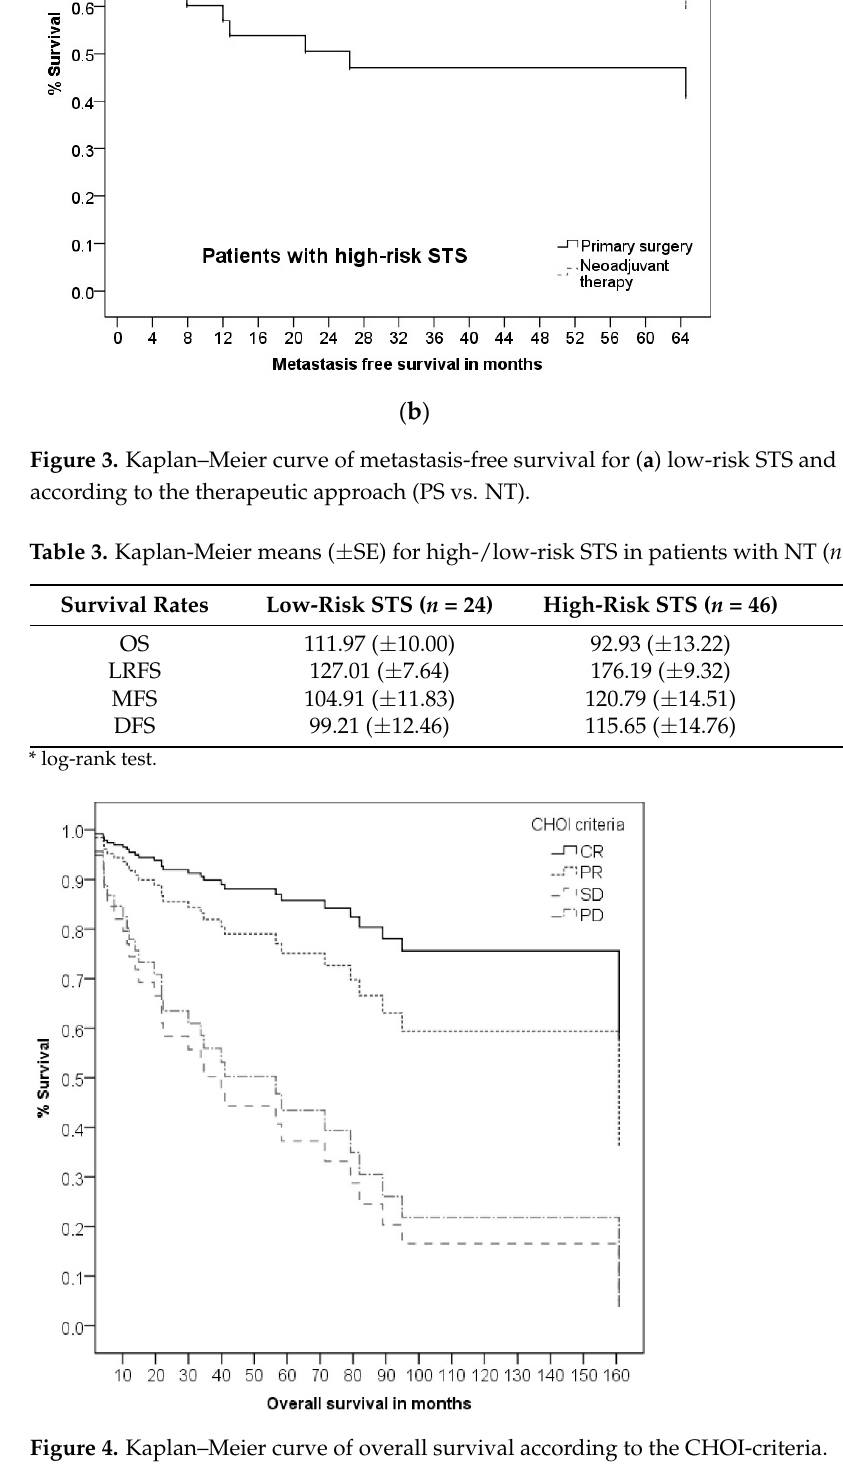
Figure 5. Kaplan–Meier curve of overall survival according to the histopathological response. Surgical margins did not affect OS ( p = 0.631), LRFS ( p = 0.555), MFS ( p = 0.871) or DFS ( p = 0.531). Patients with epifascial STS had a better OS ( p = 0.047), MFS ( p = 0.037) and DFS ( p = 0.011) than patients with subfacial STS. However, LRFS was not affected by tumor depths ( p = 0.101). The administration of NT in patients with epifascial STS did not offer any advantage regarding OS ( p = 0.318), LRFS ( p = 0.358), MFS ( p = 0.419) or DFS ( p = 0.829) in comparison to PS. The chances to develop postoperative complications was 3.13-fold higher when receiving NT in comparison to PS (Fishers exact test, χ 2 = 15.91, p = 0.001, Cramérs V = 0.33, OR = 3.13, see Figure 6).